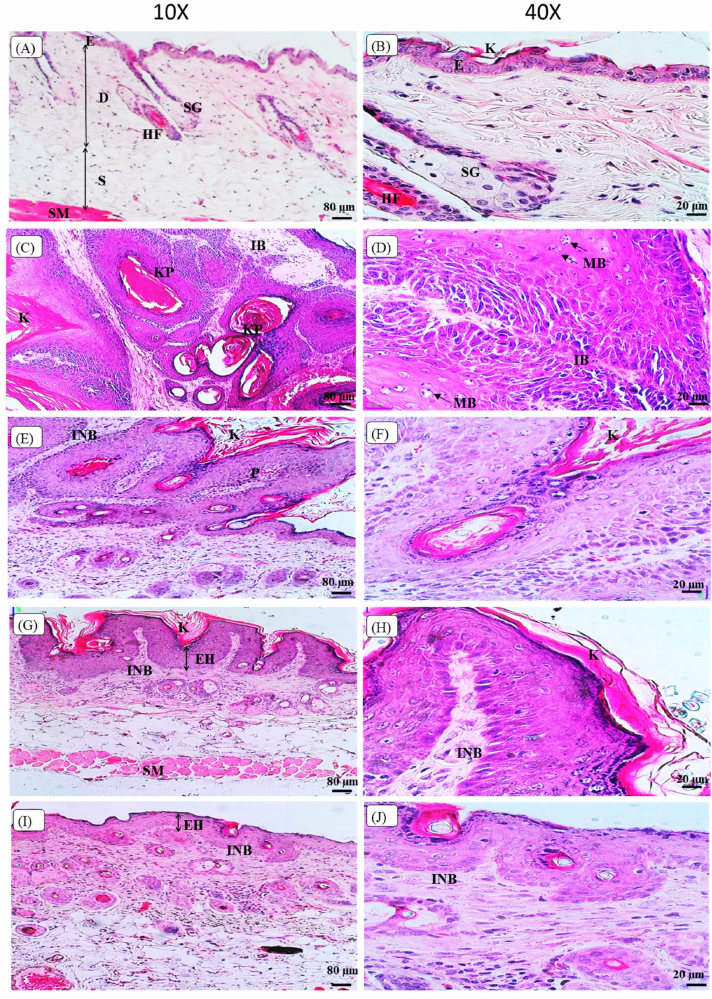
Figure 5. The images of histopathological observation of Hematoxylin and Eosin (H&E) staining under the light microscope. ( A , B ) are the skin histology of the Vehicle group with 10 × and 40 × magnification, respectively. ( C , D ) are the skin histology of the Cancer group with 10 × and 40 × magnification, respectively. ( E , F ) are the skin histology of the Initiation group with 10 × and 40 × magnification, respectively. ( G , H ) are the skin histology of the Promotion group with 10 × and 40 × magnification, respectively. ( I , J ) are the skin histology of the Continuous group with 10 × and 40 × magnification, respectively. E: epidermis layer; D: dermis layer; S: subcutaneous layer;